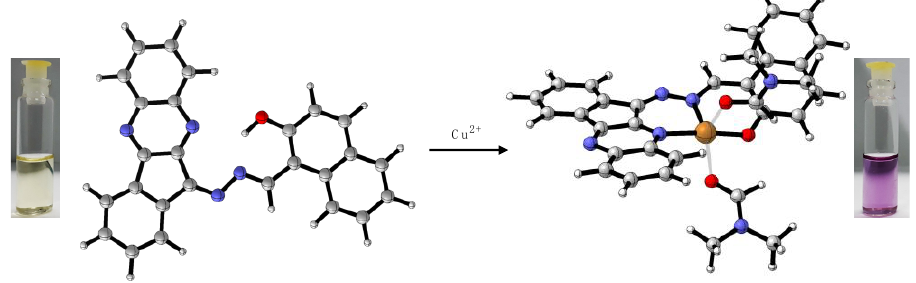
Figure 5. Proposed sensing mechanism of Cu 2+ by QNH. The displayed chemical structures shown as ball and sticks correspond to the DFT-optimized models. Colour code: C = grey; H = white; N = blue; O = red; Cu = brown.